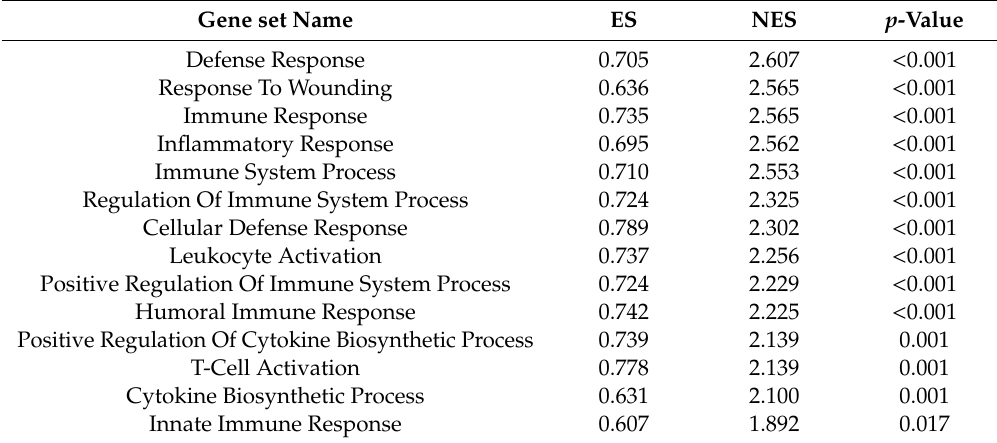
Table 2. Gene set enrichment analysis (GSEA) with immune response-related gene